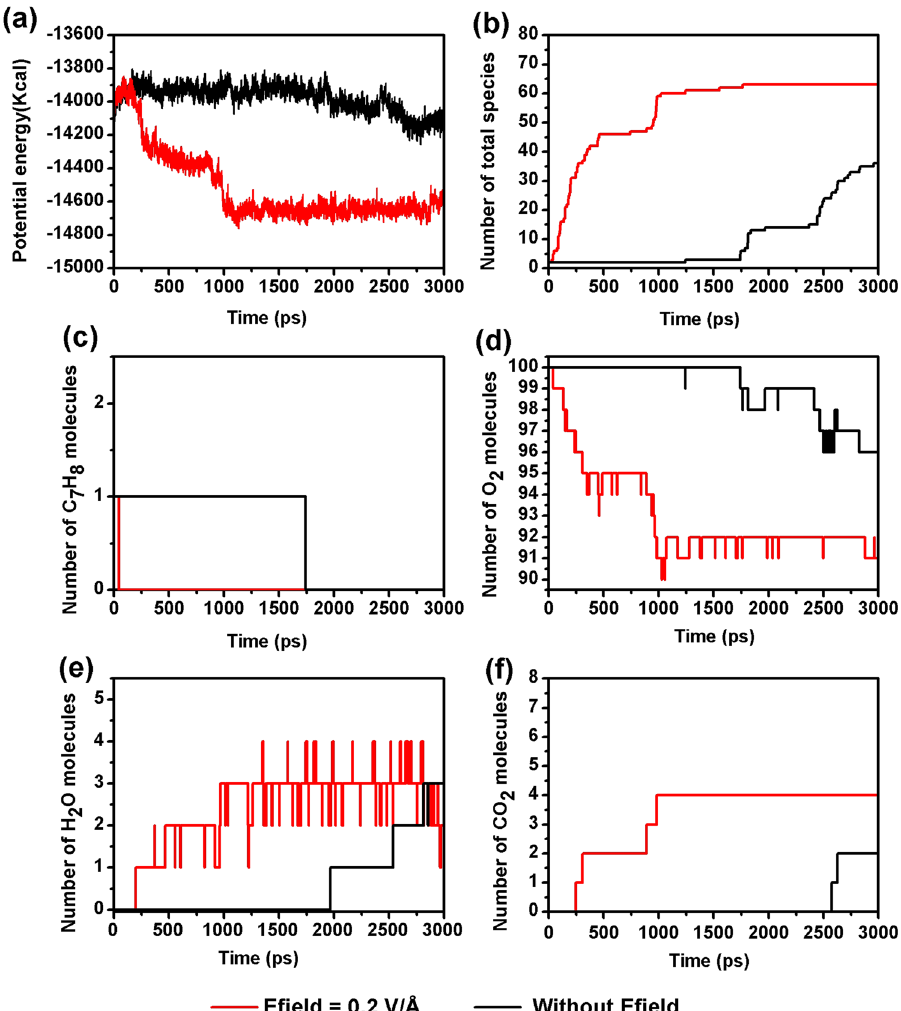
Figure 2. Evolution of the potential energies, total number of species, toluene, oxygen and main products at Efields = 0, 0.2 V/Å (ReaxFF NVT-MD simulation, T = 2500 K, ρ = 0.15 g/cm 3 , toluene/oxygen =